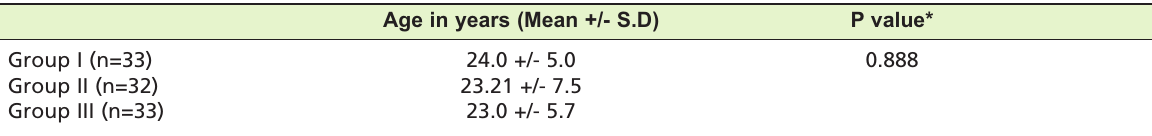
Age distribution Table I: